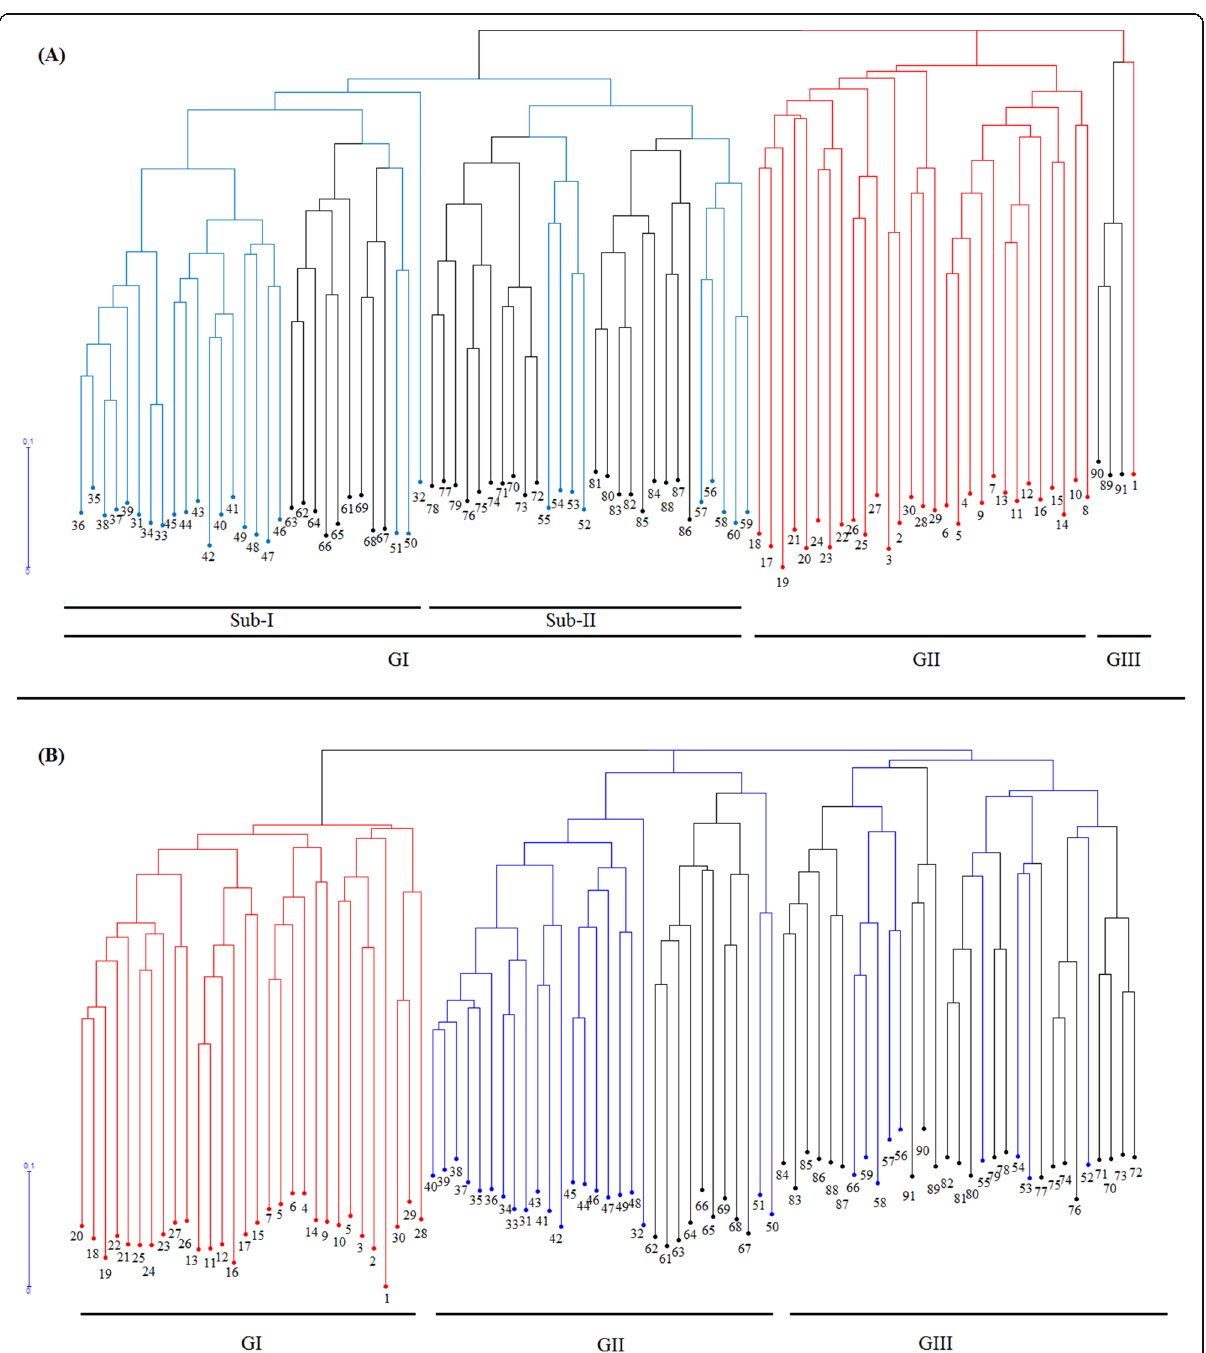
Fig. 2 Hierarchical clustering patterns of investigated accessions based on Jaccard ’ s dissimilarity coefficient using SCoT (panel a ) and CBDP (panel b ) markers. Red, black and blue lines represent the T. aestivum , Ae. cylindrica and Ae. crassa accessions,